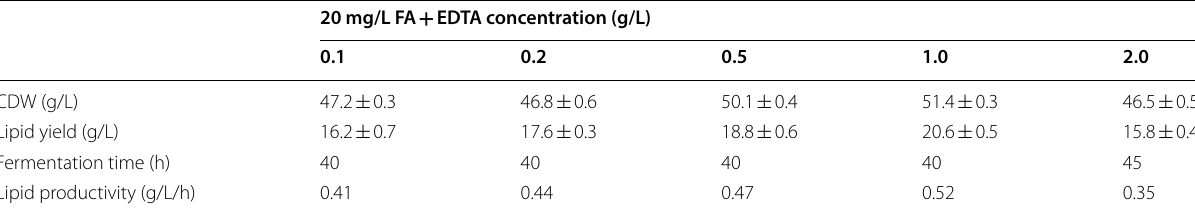
Table 2 Cell growth and lipid production of Schizochytrium sp. under different concentrations of EDTA on the premise of adding 20 mg/L fulvic acid